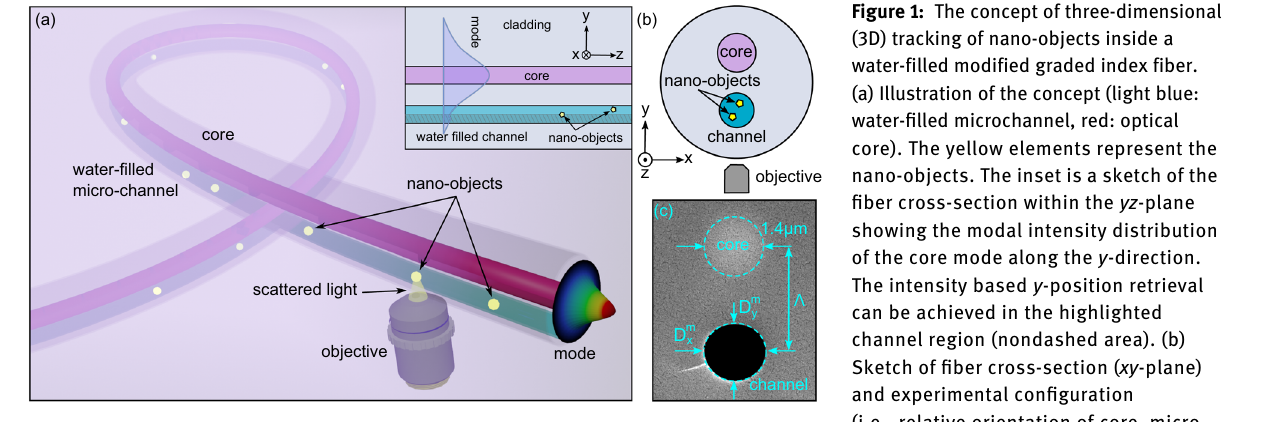
(i.e., relative orientation of core,